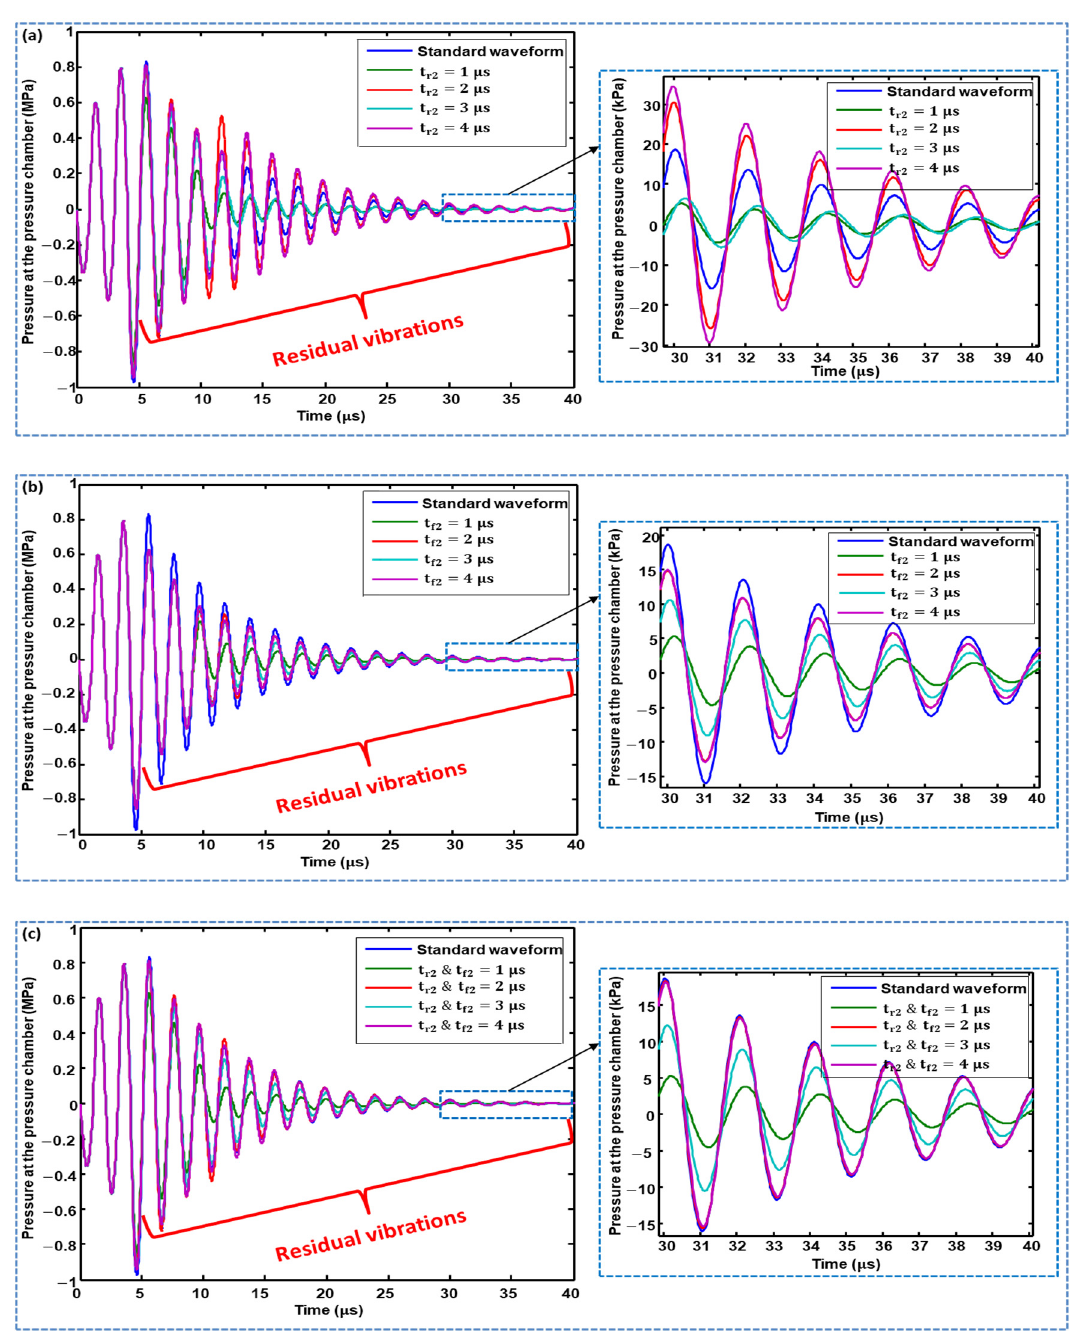
Figure 10. E ff ect of: ( a ) changing the rising time; ( b ) changing the falling time; and ( c ) simultaneously changing the rising and falling times of the second pulse of Waveform 02 on residual vibrations.